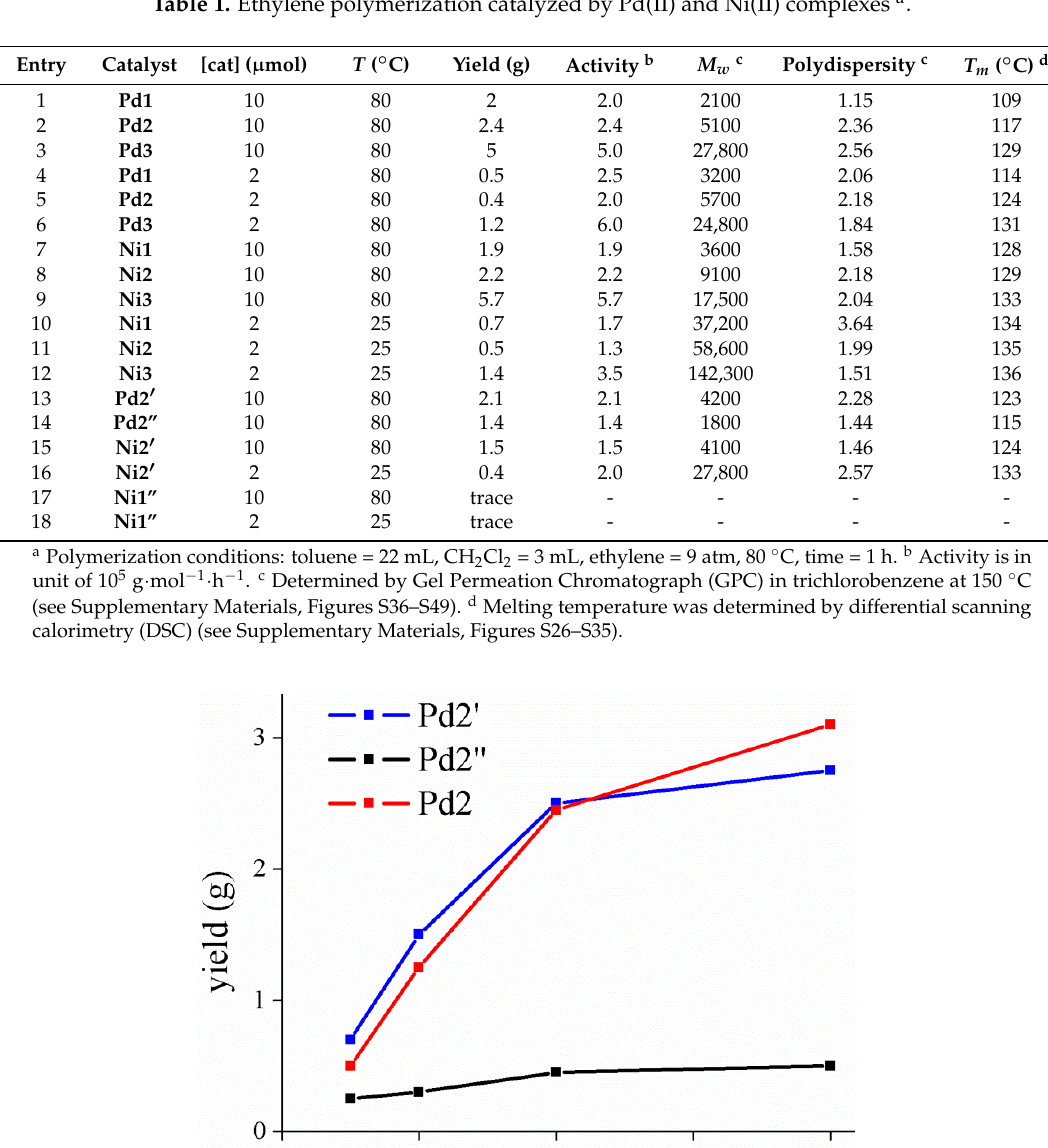
Table 1. Ethylene polymerization catalyzed by Pd(II) and Ni(II) complexes a .